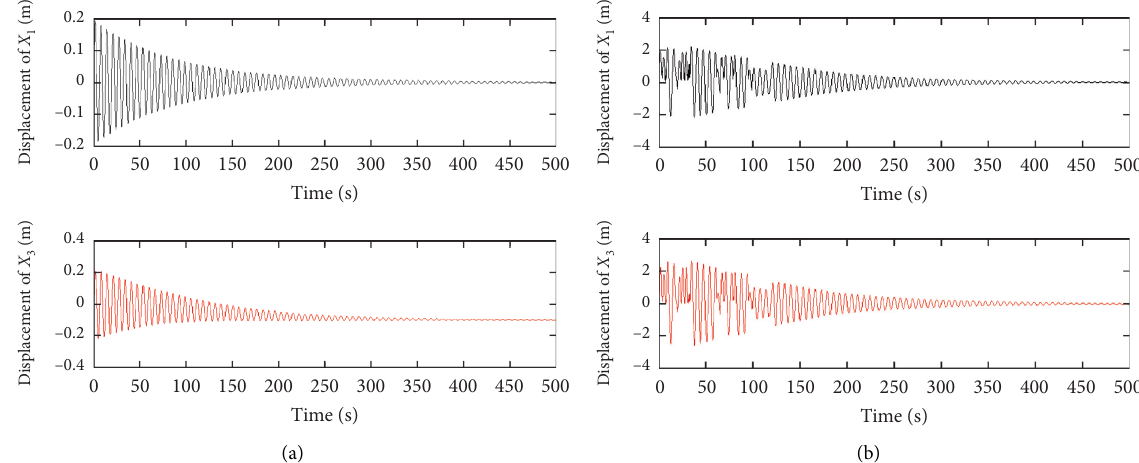
� 0.35m/s, h � 0.01, and T � 500 0